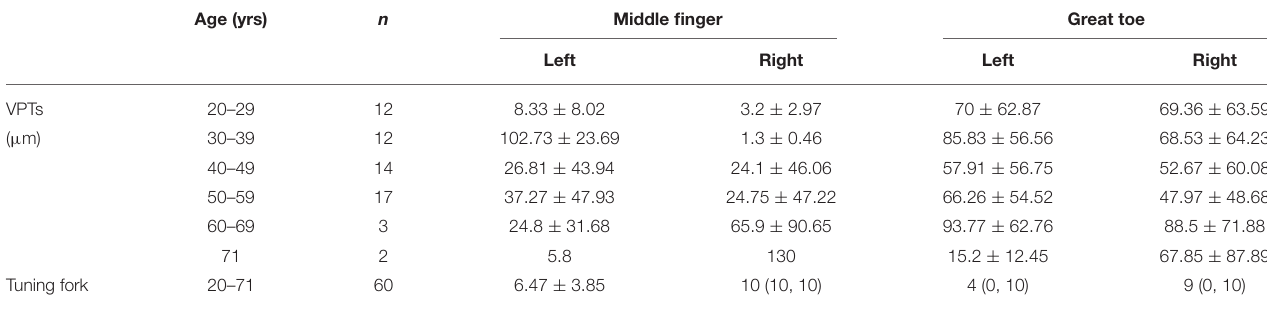
TABLE 3 | VPTs measured with VSA-3000 and tuning fork scores.